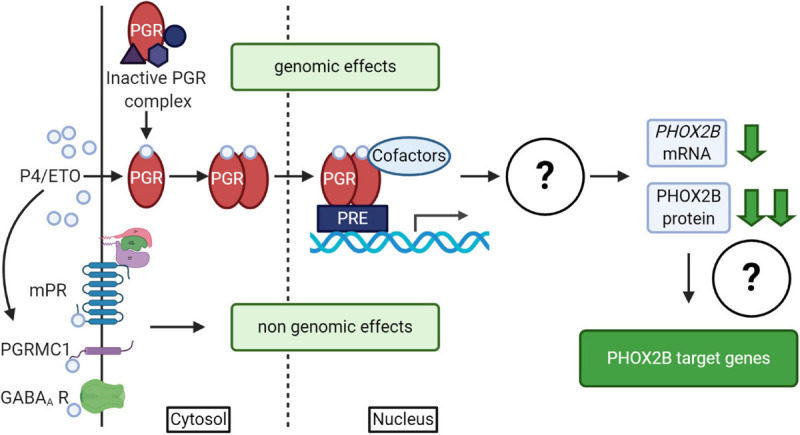
(Created with BioRender.com). Schematic diagram of progesterone (P4)/progestins signaling pathways. Genomic effects of P4/ETO are mediated by nuclear progesterone receptor (PGR) which is inactive in the cytosol until progesterone binding. After P4 binding, it form dimers, translocates to the nucleus and dimers bind to Progesterone Responsive Element (PRE) within gene promoters and regulate the expression of target genes. The scheme also shows that the activation of PGR receptor by ETO is able to induce PHOX2B down-regulation by unknown mechanisms (Cardani et al., 2018), with possible effects on the expression of some PHOX2B target genes. Non-genomic effects of P4/ETO are mediated by the binding of P4 to cognate membrane receptors (mPR and PGRMC1) or to those belonging to other neurotransmitters (such as GABAA receptors).